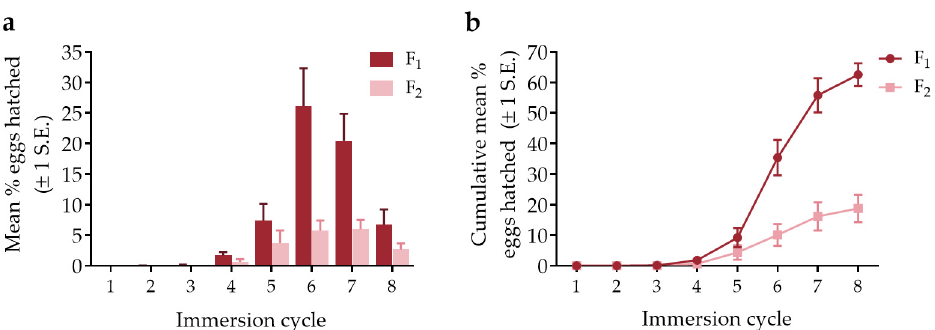
Figure 3. Haemagogus janthinomys egg eclosion shown for the first eight immersion cycles for N = 10 Figure 3. XXXX.